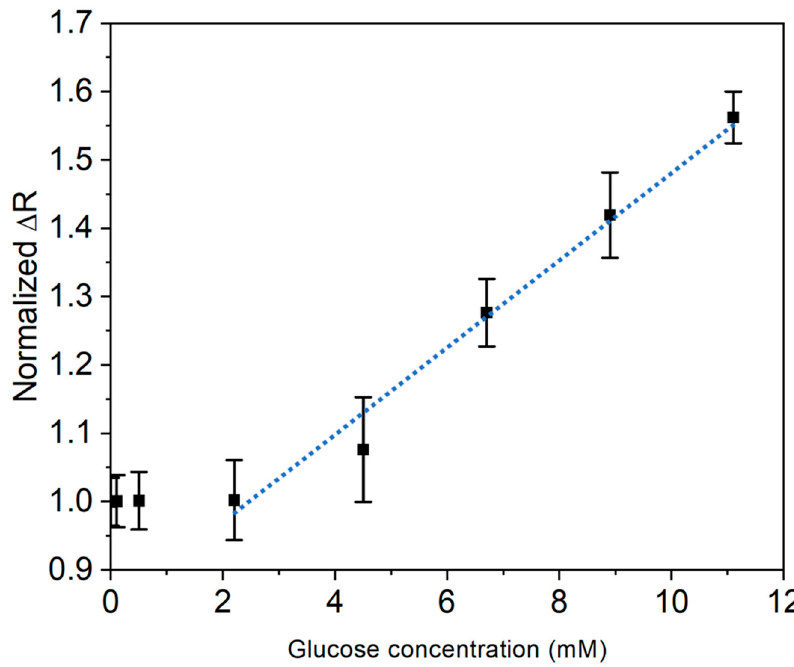
Figure 8. Graph of the normalized resistance change ratio as a function of the added glucose concentrastion in the bovine blood sample. The calibration curve (blue dash) of glucose concentration shows linear correlation ranging from 2.2 to 11.1 mM. Each point represents an average of at least three identical tests on di ff erent paper sensors. The error bars represent the standard deviations calculated based on the resistance ratio measurements.